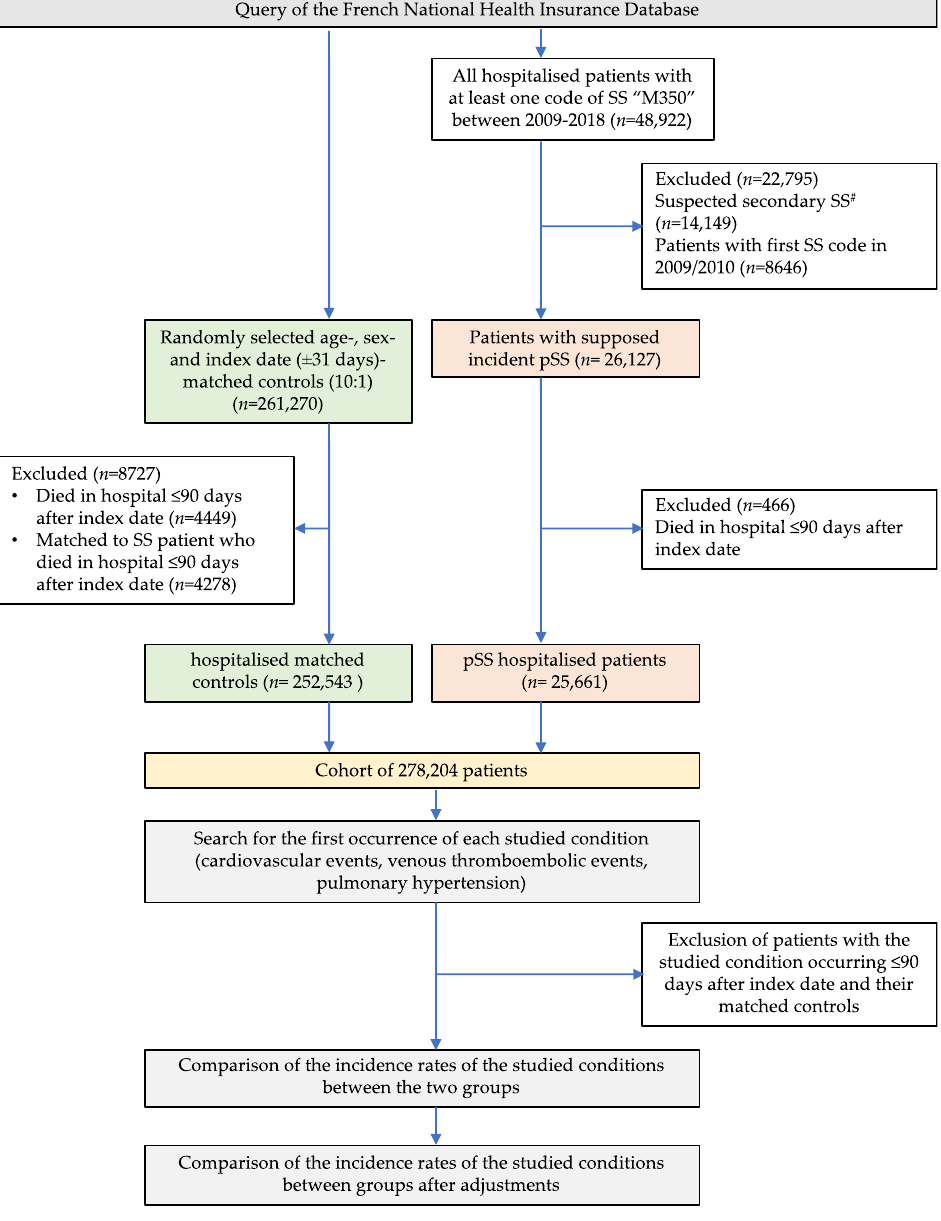
Figure 1. Flow chart of the selection of hospitalised primary Sjögren’s syndrome patients and their matched controls. # Presence of another code of autoimmune disease during the same study period; autoimmune diseases classifying SS as secondary are reported in Supplementary Table